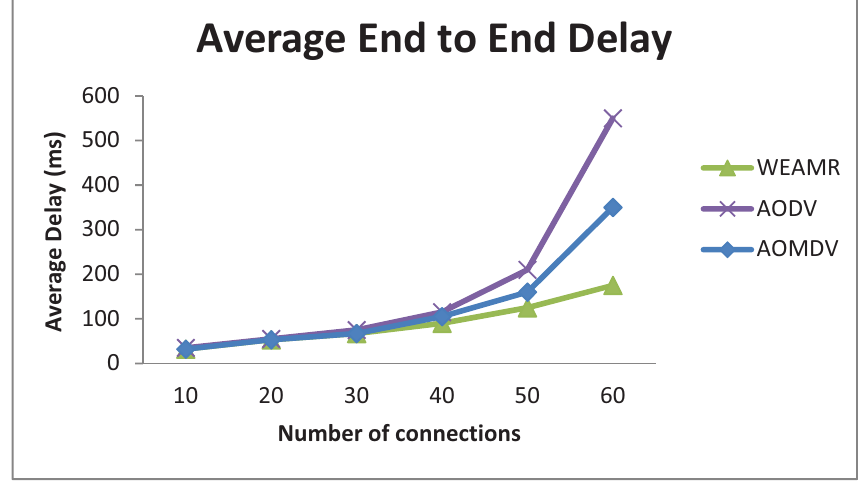
Figure 10. Average end to end delay with increasing number of connections.